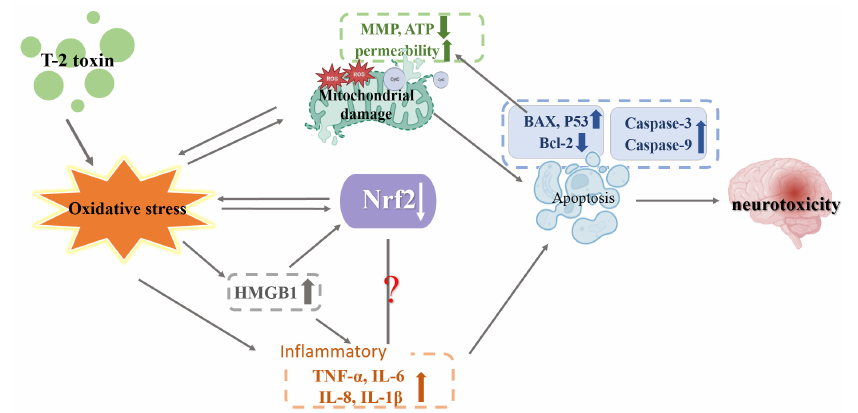
Figure 6. Mechanism of neurotoxicity induced by T-2 toxin. T-2 toxins cause oxidative stress. Oxi- dative stress leads to mitochondrial damage (decreased MMP and ATP content, increased mito- chondrial permeability, ROS production and increased cytochrome exudation), and mitochondrial damage leads to apoptosis (increased expression of caspase-3, caspase-9, BAX and P53, decreased expression of Bcl-2), which results in neurotoxicity. Increased expression of BAX and P53 exacer- bates mitochondrial damage, and ROS produced by mitochondrial damage further increases oxi- dative stress. Oxidative stress leads to decreased Nrf2 expression, which in turn exacerbates oxida- tive stress. Oxidative stress leads to increased expression of HMGB1, which in turn leads to de- creased expression of Nrf2 and increased expression of inflammatory factors (TNF- α , IL-6, IL-8 and IL-1 β ), and increased expression of inflammatory factors promotes cell apoptosis. Oxidative stress leads to increased expression of inflammatory factors. The relationship between Nrf2 and inflammation is unclear.